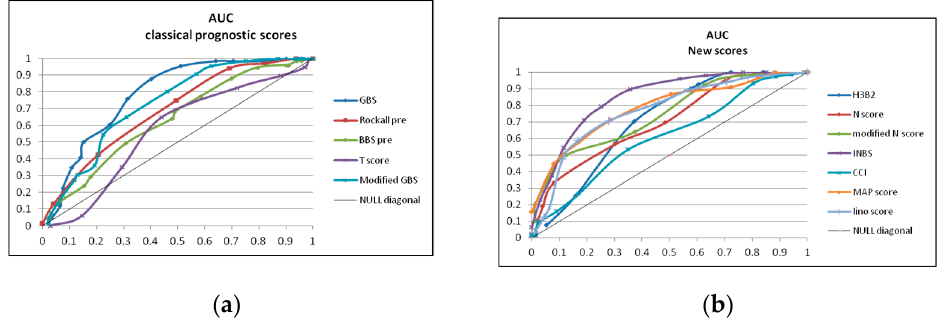
Figure 1. ( a ) Area under the curve for GBS, mGBS, AIM65, T-score and Baylor score (pre-endoscopic and after endoscopy); ( b ) New proposed scores: H3B2, Iino score, original and modified N-score International Bleeding score (INBS), MAP score and CCI.